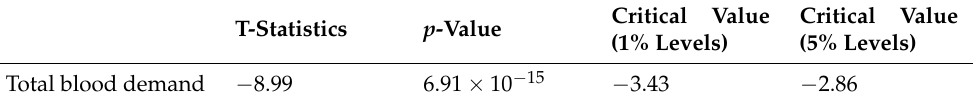
Table 7. Augmented Dickey–Fuller test for Total Blood Demand. Decision: (T-statistics > Critical values).